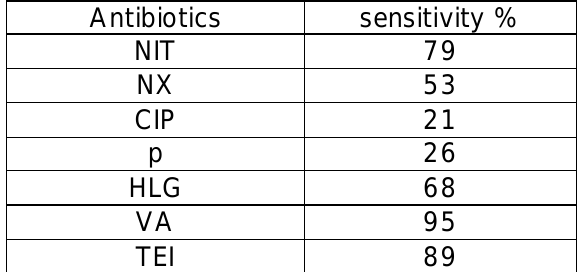
Table 2: Gender distribution for rate of isolation